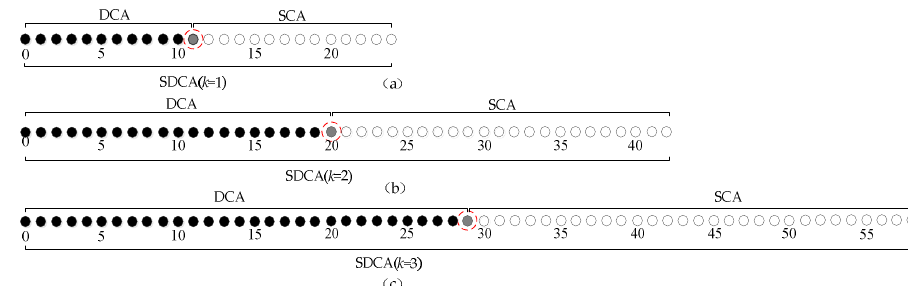
Figure 3. The SDCAs of the k -level extended array with N 1 = N 2 = 3: ( a ) k = 1; ( b ) k = 2; ( c ) k = 3, where black circles, white circles and grey circles, respectively, denote DCA, consecutive parts of SCA, and the overlapping sensors, the overlapping virtual sensors are also marked by red dashed circle boxes.